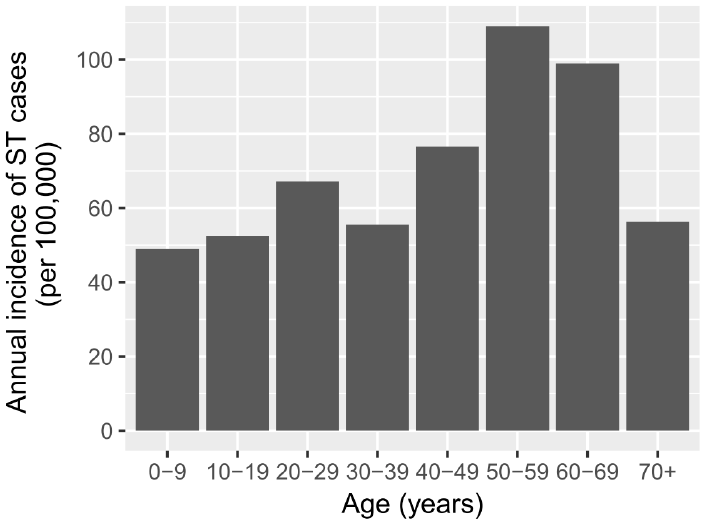
Figure 2. Age-specific incidences of 470 clinically suspected ST cases that were positive to the SD Bioline Tsutsugamushi test in Bhutan in 2015.